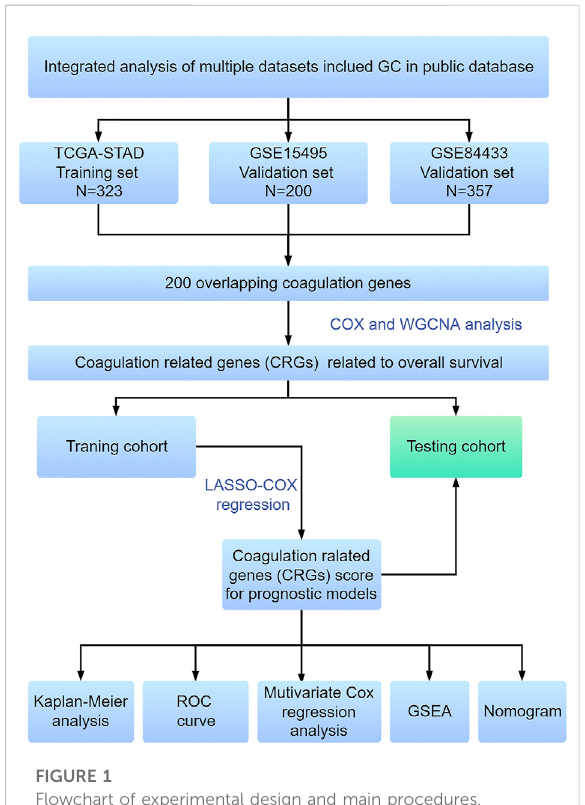
FIGURE 1 Flowchart of experimental design and main